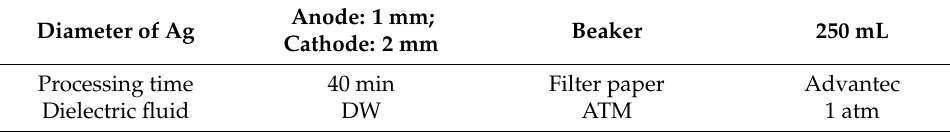
Table 6. Materials and testing conditions of the EDM.